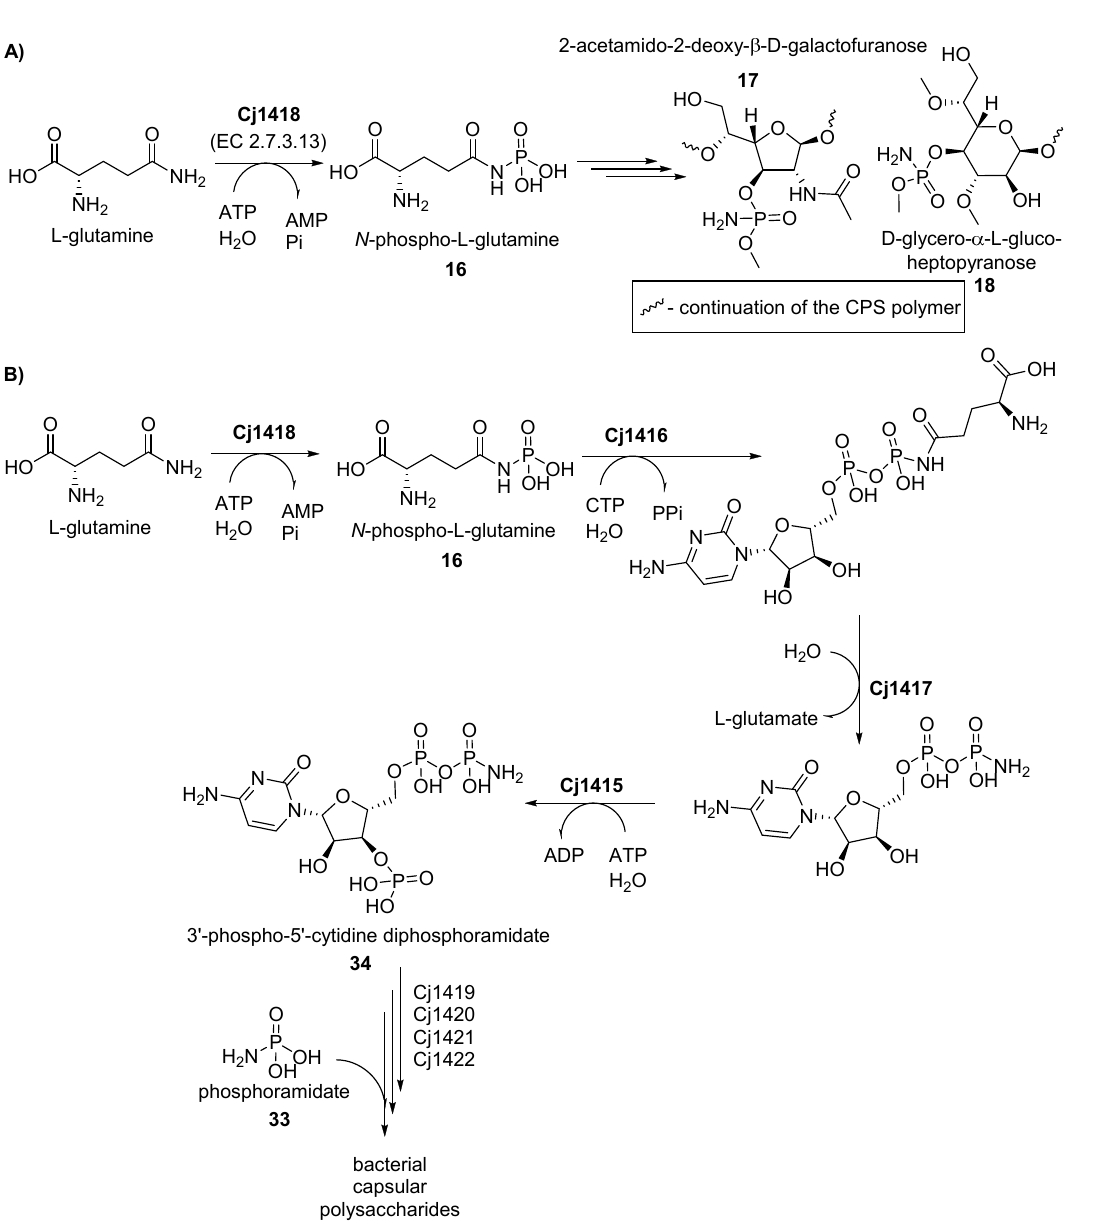
Figure 3. ( A ) The initial transformation in the biosynthetic pathway for the phosphoramidate modification of the sugar residues in the bacterial capsular polysaccharides (CPS) proceeds via direct phosphorylation of the amide nitrogen of L -glutamine with ATP by a specific L-glutamine kinase (EC 2.7.3.13) to form N -phospho- L -glutamine ( 16 ). ( B ) Compound 16 is a precursor for P–N bond-containing sugar residues ( 17 , 18 ) of the CPS and it is proposed to undergo a series of transformations before the formation of the final CPS product (with the formation of inorganic phosphoramidate ( 33 ) and 3 ′ -Phospho-5 ′ -cytidine diphosphoramidate ( 34 ) as P–N bond-containing intermediates) [46–49]. Enzymes from Campylobacter jejuni CPS biosynthetic gene cluster with the known function in the CPS biosynthetic pathway are marked in bold font.